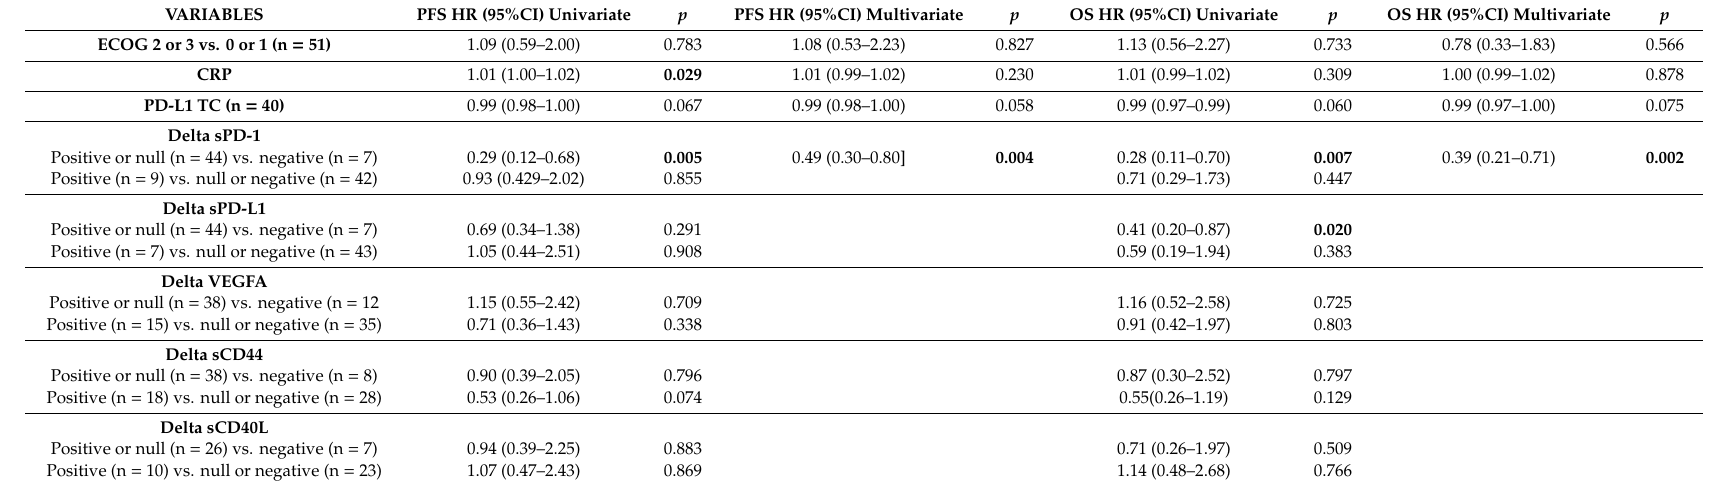
Table 3. Univariate and multivariate Cox proportional hazard analyses of progression-free survival (PFS) and overall survival (OS) according to plasma biomarker evolution between baseline and day 28 among patients treated with